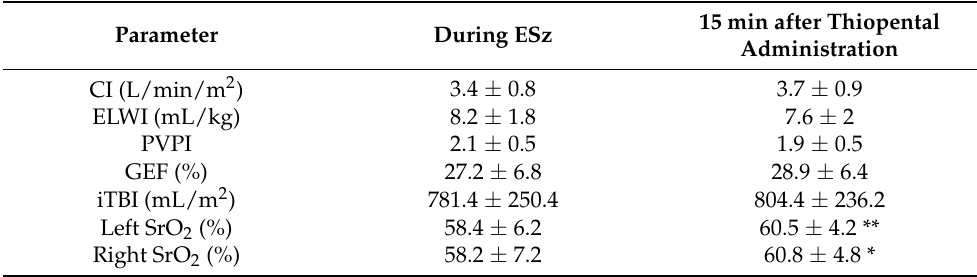
Table 2. Changes in cardiac index (CI), extravascular lung water index (ELWI), pulmonary vascular permeability index (PVPI), global ejection fraction (GEF), intrathoracic blood volume (iTBI), and regional cerebral oxygenation (SrO 2 ) in the right and left hemispheres during ESz and 15 min after their suppression with continuous thiopental infusion at the dose of 50 µ g · kg − 1 · min − 1 . * p < 0.05, ** p < 0.01—differences in SrO 2 noted before and after suppression of